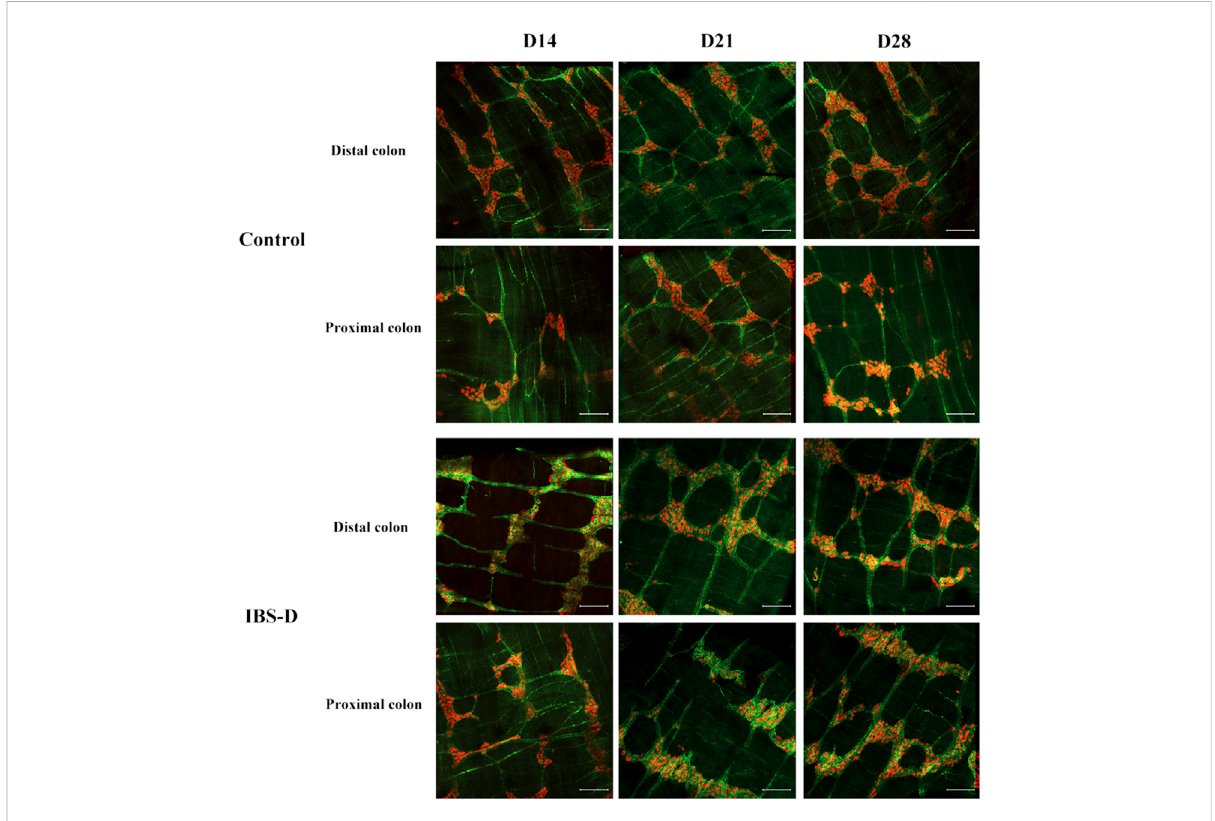
FIGURE 3 SubstanceP (SP)was alteredin IBS-D rats. SPproteinsphotographedbylaserconfocal microscopy. Immuno fl uorescence resultsofSP positive neurons in the proximal and distal colon of IBS-D rats at day 14, day 21, and day 28. HuC/D (Red), SP(Green). Scale Bar = 100 μ